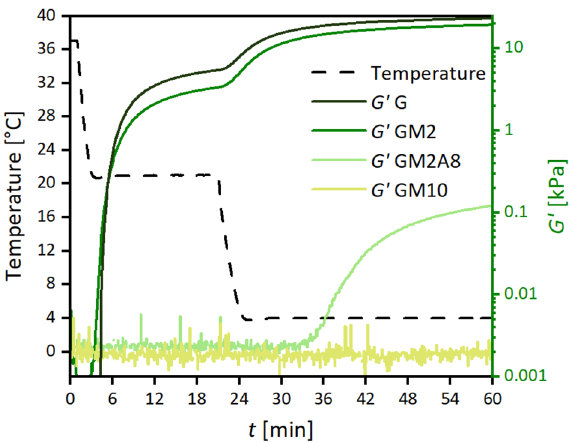
Figure 3. Evolution of storage modulus G ′ during the initial cooling protocol of the sequential cross-linking procedure for the tested gelatin derivatives and the raw material gelatin (G). Note that the data on the subsequently performed chemical cross-linking of the samples shown here is depicted in Fig. 4 and discussed in the next section. The figure was created with Origin 2019b (https ://www.origi nlab.com/2019b ).